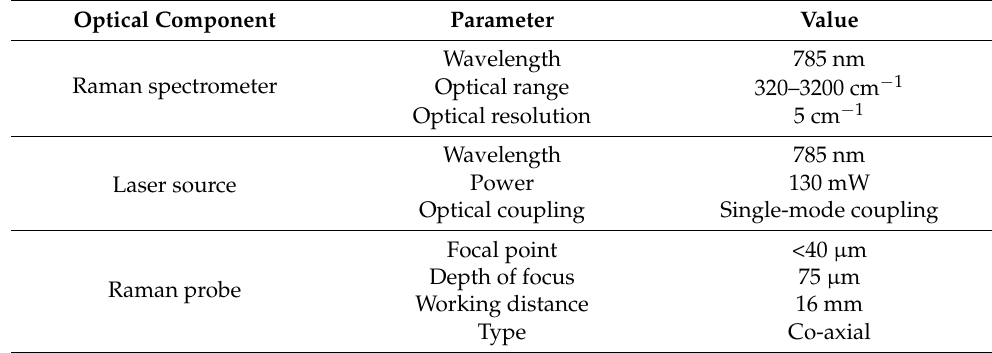
Table 2. Optical components.